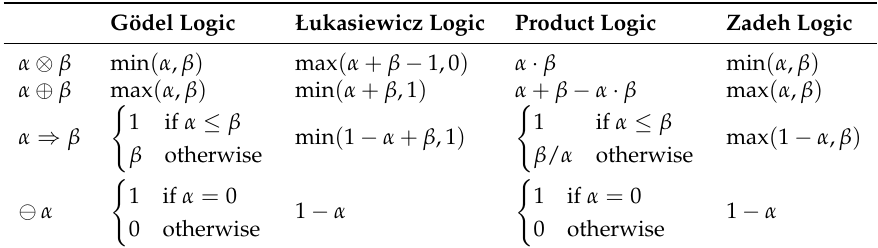
Table 1. Combination functions of various fuzzy logics [24].